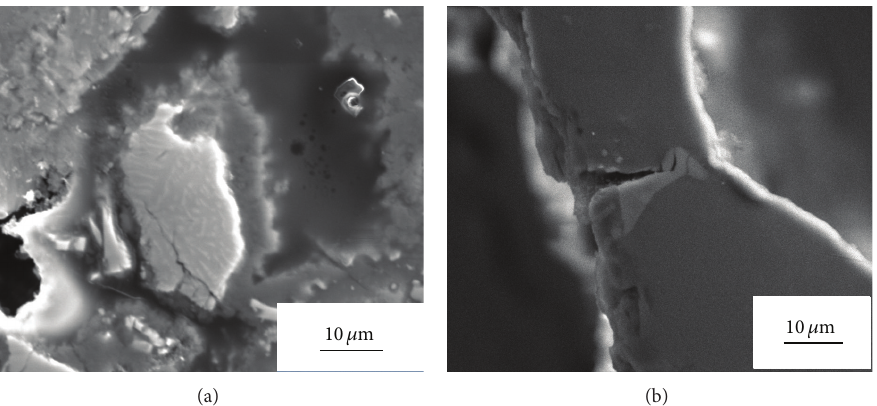
Figure 3: SEM images of the cell wall material for (a) hydride and (b) carbonate kinds of Al foams (F12, F13) based on Al-Zn-Mg alloy and performed (b) with (F13) and (a) without (F12) Ca additive: (a) cracks within partly converted TiH 2 , (b) crack lengthways the domain of redundant